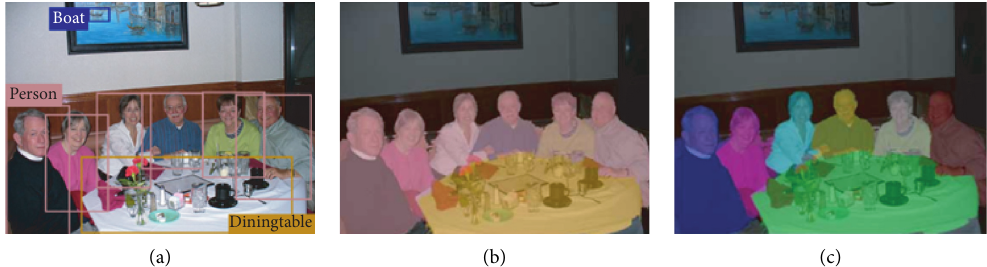
Figure 1: Illustration of differences in segmentation: (a) object detection, (b) semantic segmentation, and (c) instance segmentation